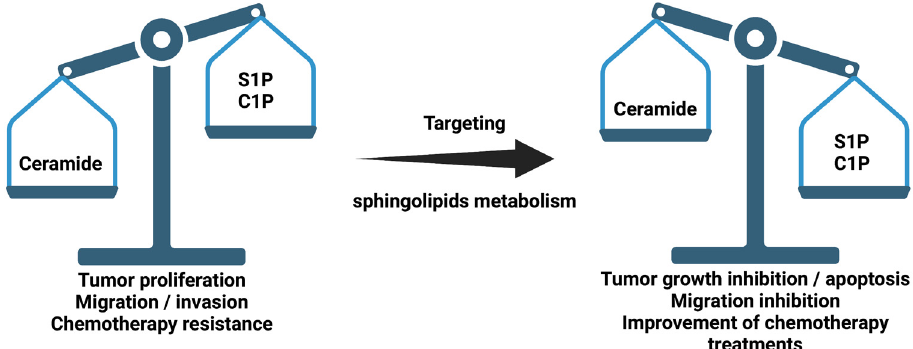
Figure 1. Schematic representation of sphingolipid ratio and their relationship with cancer. Sphingosine 1-phosphate (S1P) and ceramide 1-phosphate (C1P).